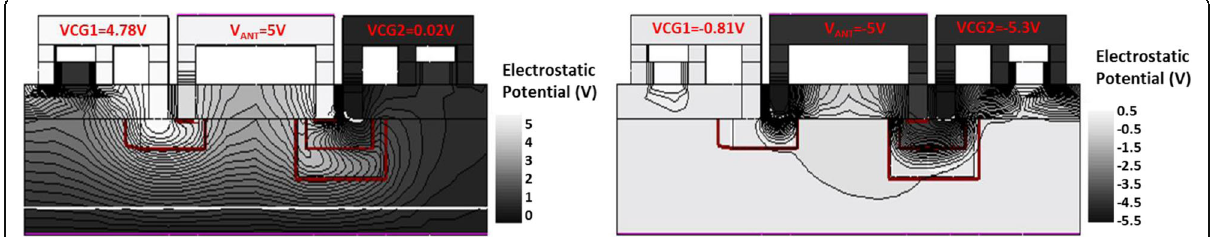
Fig. 5 Simulated potential distribution in CSIR with positive and negative antenna gate voltage. The forward and reverse pn diodes successfully separate the antenna charge